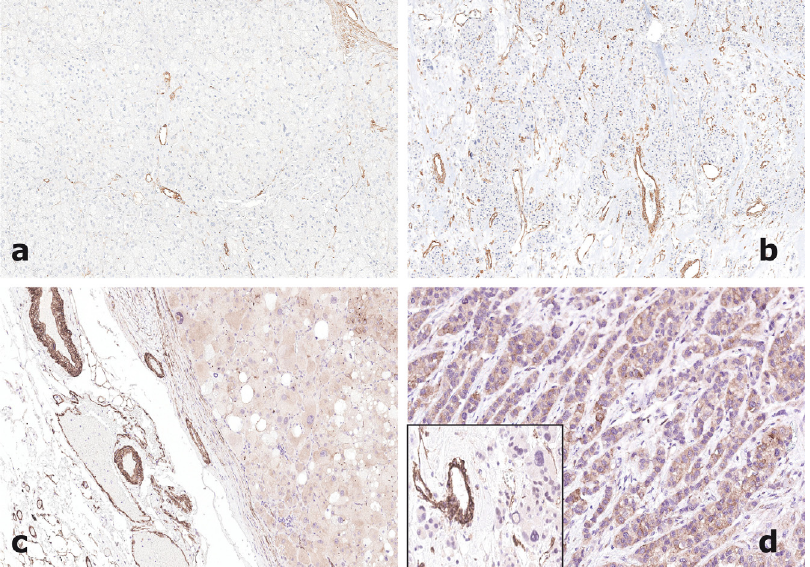
Figure 2. Laminin α 3 immunoexpression is restricted to the vascular network of both an adrenocortical adenoma with rare and thin vessels ( a , 100×) and an adrenocortical carcinoma containing numerous small and medium size vessels ( b , 100×). Hyaluronan synthase-1 is also strongly expressed by smooth muscle cells of vessel walls in both adrenocortical adenoma ( c , 100×) and carcinoma ( d inset, 200×). In addition, tumor cells of adenomas present more frequently a negative or weakly positive pattern of staining ( c , 100×), while carcinoma cells may show a strong cytoplasmic reactivity ( d , 100×).